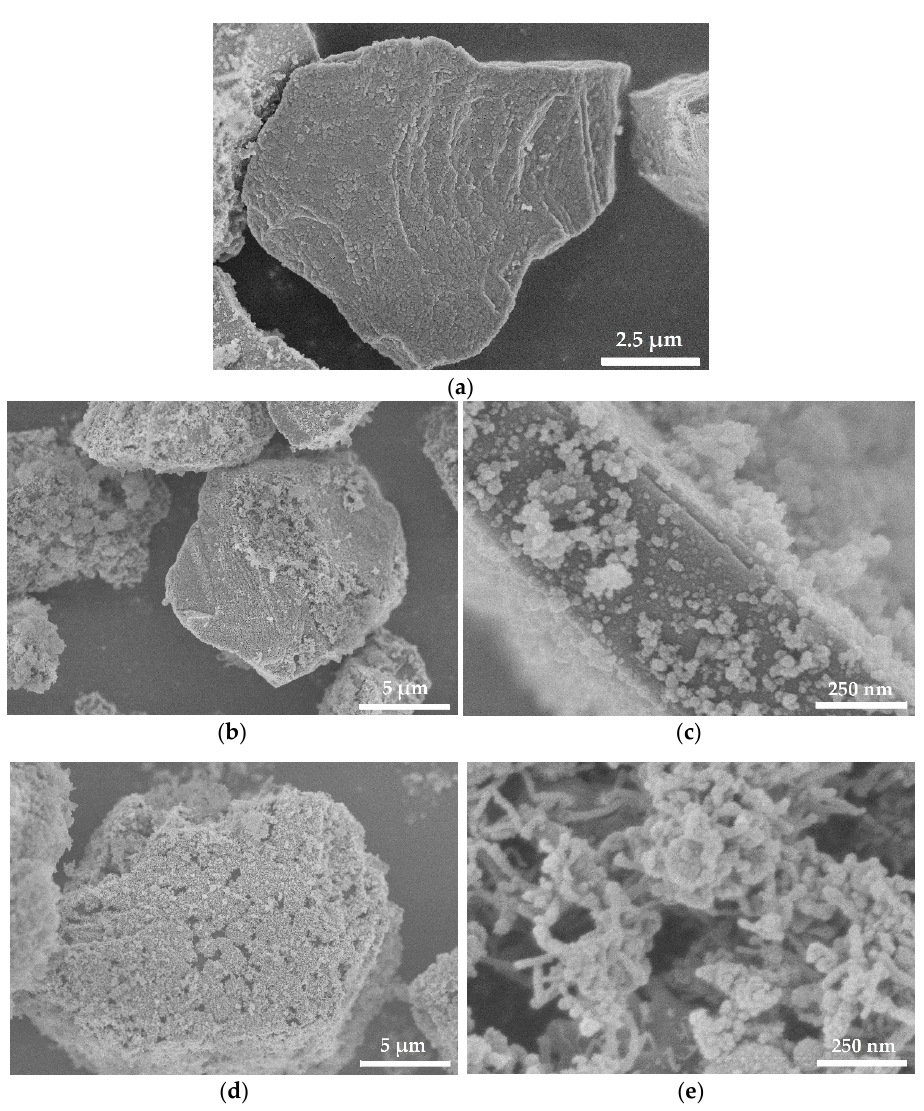
Figure 1. Scanning electron microscopy (SEM) image of modified particles SiC@C ( a ), SiC@C/NP ( b , c ), SiC@C/NW ( d , e ). Table 1. The maximum value of the filler’s volume fraction in the composite.